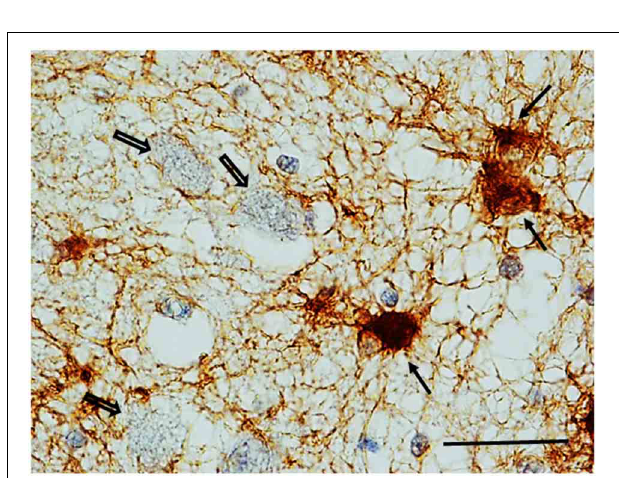
FIGURE 6 | Hypoplasia of the Kölliker-Fuse nucleus in a SIUDS case (39 gestational weeks). The boxed area in (A) is represented at higher magnification in (B) . At this magnification only rare suffering Kölliker-Fuse